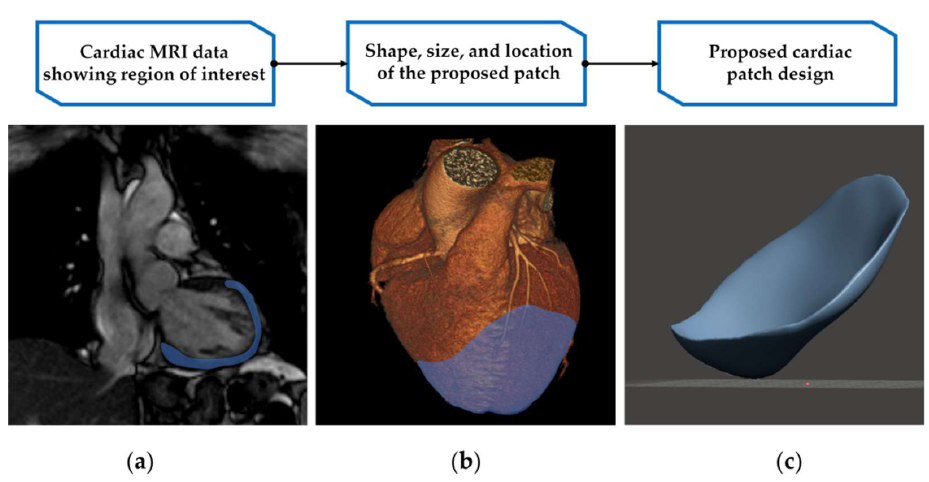
Figure 2. Using cardiac MRI and cardiac CT data for creating a 3D presentation of the cardiac patch model: ( a ) cardiac MRI viewed on the short axis plane, a region of interest on the left ventricle and the apical area highlighted in blue (DICOM image sample sets from [92]); ( b ) anatomy of the whole heart is captured from a cardiac CT scan with the region of interest highlighted in blue (DICOM image sample sets from [92]; ( c ) a proposal for a 3D model of a cardiac patch based on a digital model created from cardiac imaging data.